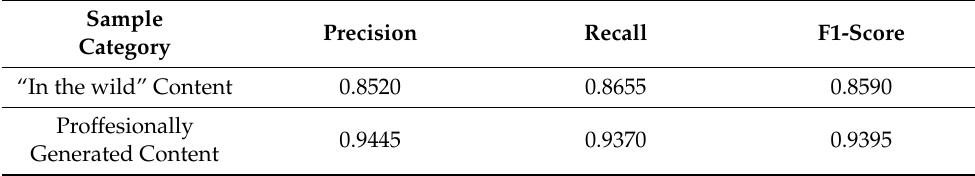
Table 4. XGBoost results based on sample